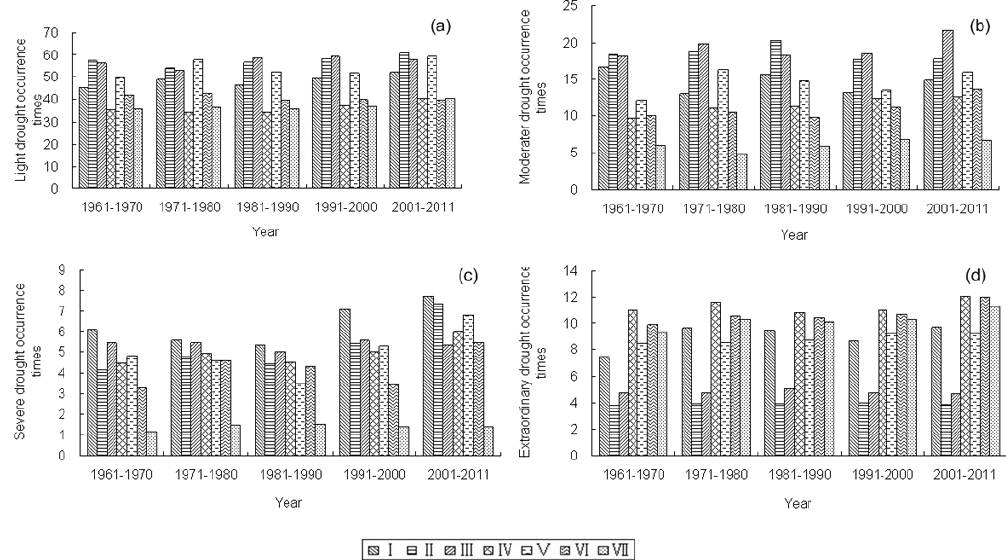
Fig. 4. Interdecadal changes of light (a) , moderate (b) , severe (c) and extraordinary (d) droughts; occurrence times of the seven subareas. Note: I – areas surrounding Bo Sea and the Shandong Peninsula; II – Huai River downstream; III – piedmont plains of upper and middle reaches of the Huai and Hai River basins; IV – Hetao Plains and Inner Mongolia Plateau; V – Loess Plateau and Fen–Wei Valley basin; VI – mountains and hills at altitudes of 1500–3000m; VII – Tibetan Plateau at altitudes above